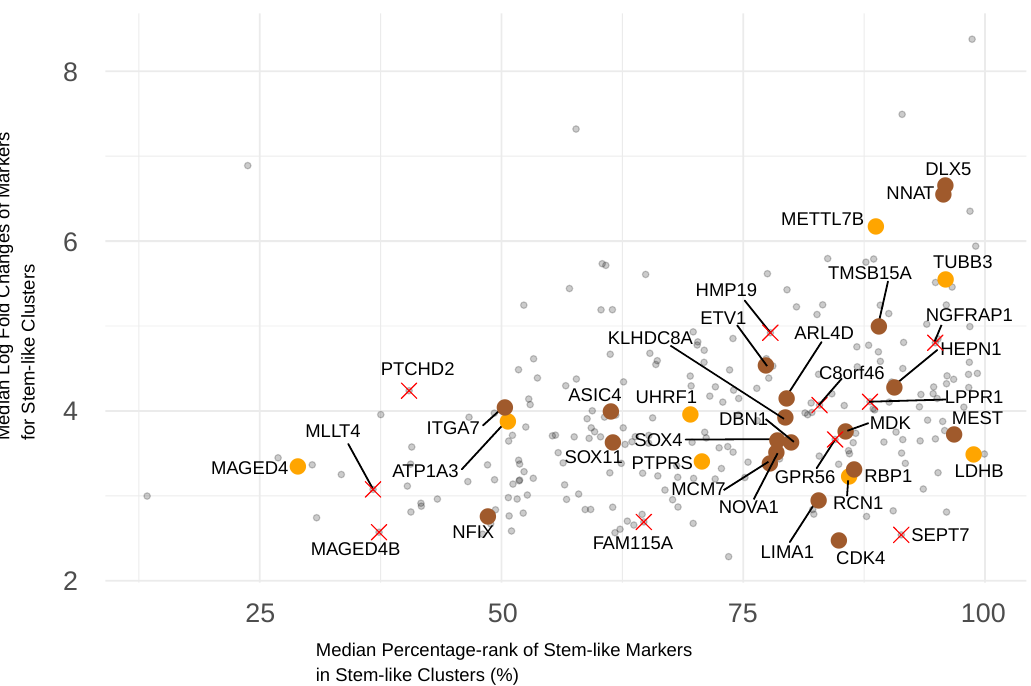
Figure 4. Selection of markers based on expression and overexpression in the stem-like subtype. The expression level of the gene is represented by the median percentage-rank, and the overexpression is shown by logFC obtained from the analysis of cluster markers. All the markers selected by comparison with normal brain cells are also marked using the same colors and shapes as in Figure 2c. The median was taken across all the cells in the stem-like